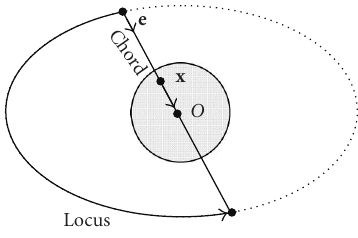
The reconstructed object is the 2D slice at x 03 = − 2 . 5 cm